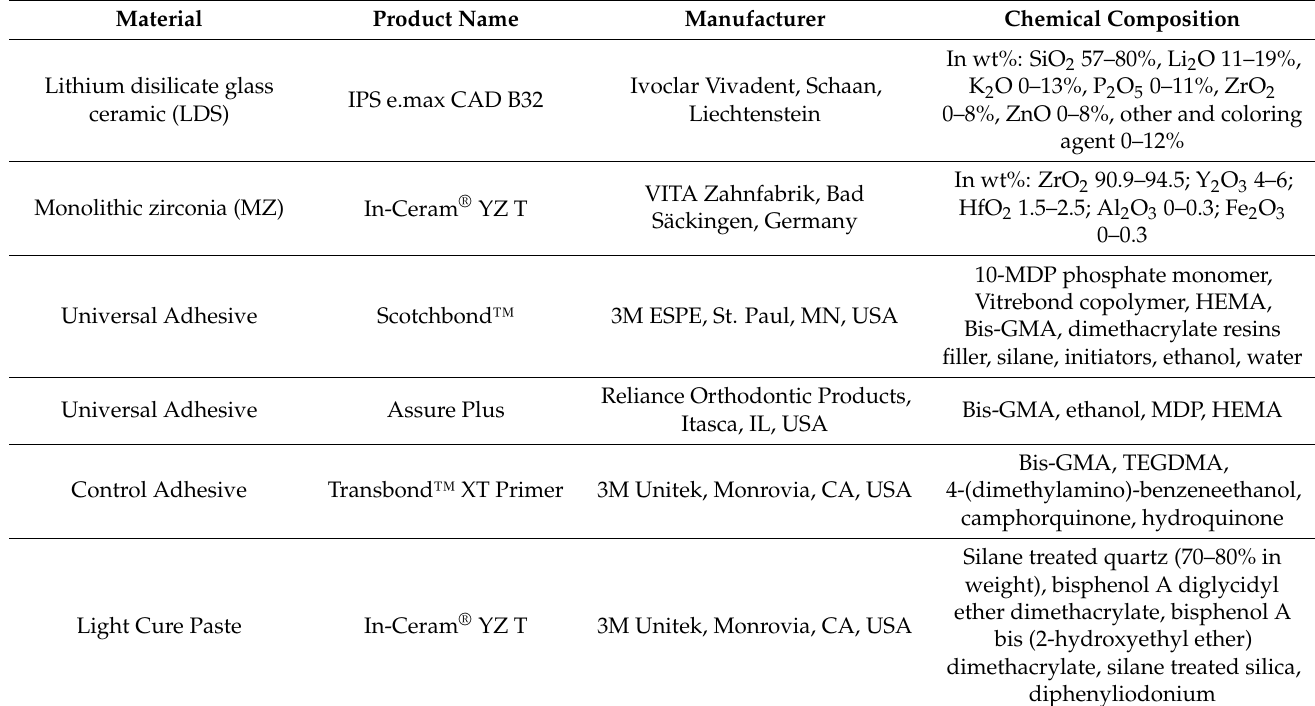
Table 1. Chemical composition of the tested ceramic blocks and